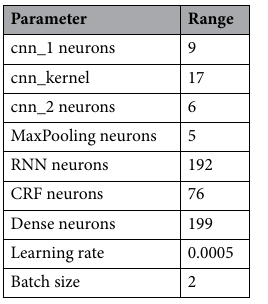
Table 3. Hyperparameter optimization